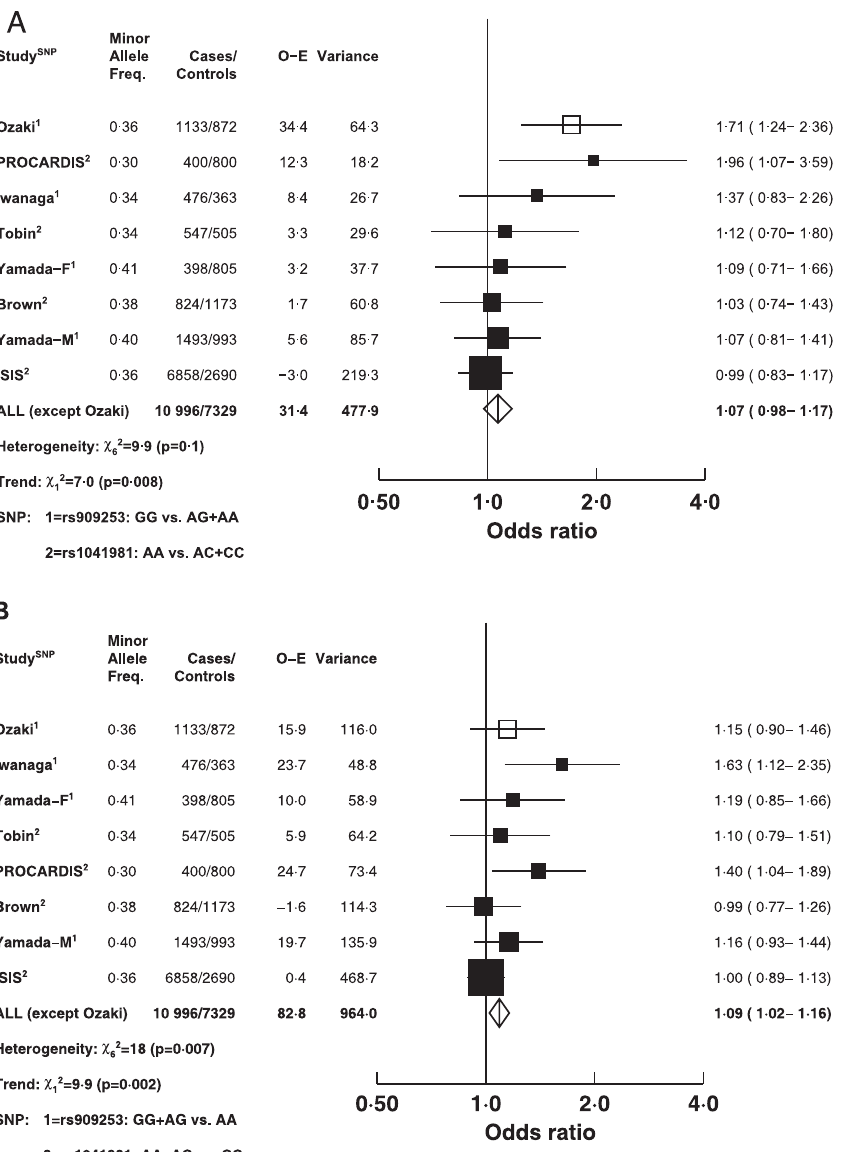
Figure 1. Odds ratio (CI) for Coronary Heart Disease Associated with Genotypes of the LTA Gene in ISIS and Other Studies Using Recessive and Dominant Models (A) shows the recessive model and (B) shows the dominant model. Studies are of either the rs909253 SNP (A/G alleles) or the rs1041981 SNP (A/C alleles). The hypothesis-generating study [5] has been excluded from the combined estimates for all other studies that tested the hypothesised association. Size of the squares is proportional to the variance of the log odds ratio, and horizontal lines represent the 99% CIs, and the width of the diamonds represents the 95% CIs. The associations have not been adjusted for age or